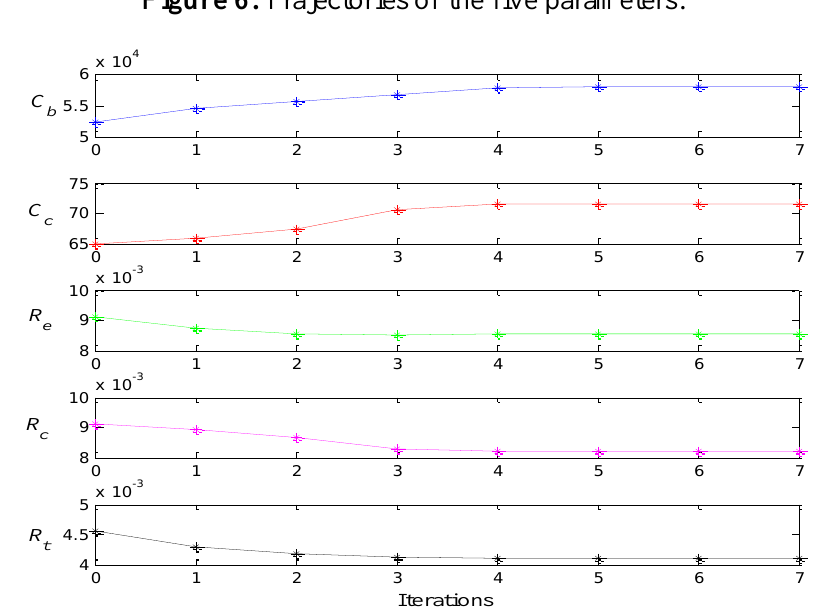
Figure 6. Trajectories of the five parameters.